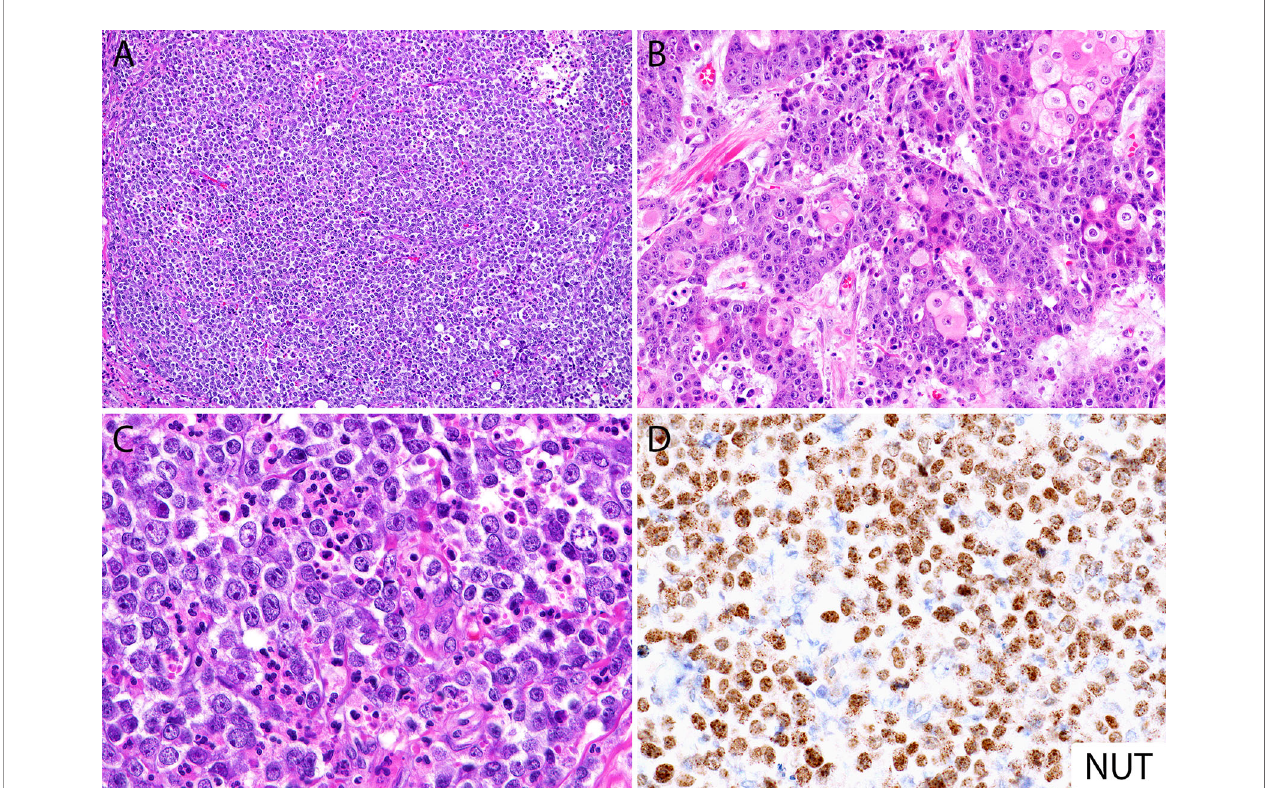
FIGURE 1 | Histomorphology of NUT carcinoma and diagnosis by immunohistochemistry. (A) Diffuse sheets of poorly differentiated monotonous round cells with focal necrosis (top right). (B) Areas with abrupt keratinization in NC can be seen in up to 30% of cases. (C) Focal cytoplasmic clearing and intratumoral neutrophilic in fl ammatory in fi ltrate. (D) NUT immunohistochemical stain (monoclonal antibody, clone C52) shows diffuse nuclear labeling, often with a speckled pattern. Same case from panel (B)